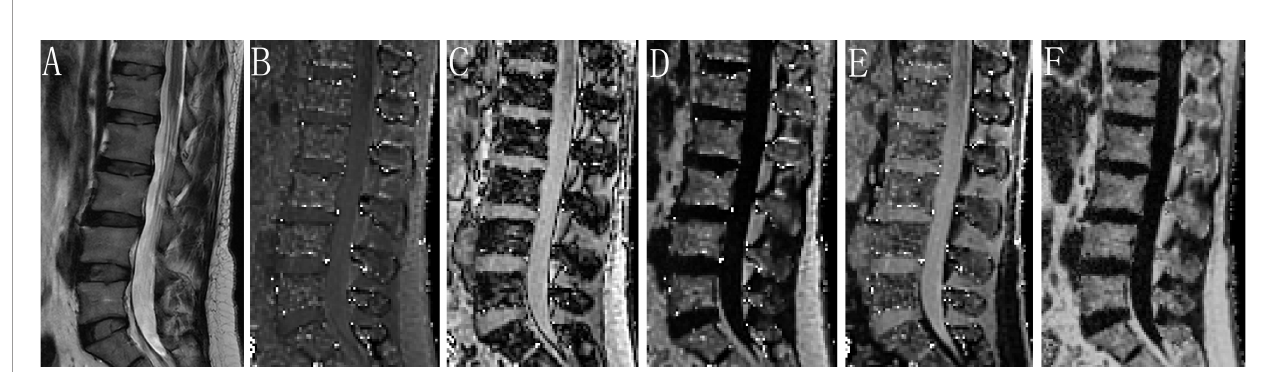
FIGURE 2 | Assessment of PDFF derived from six-echo FACT sequence in image set of a healthy woman. Sagittal T2-weighted (A) , in-phase (B) , out-of-phase (C) , fat-only (D) , water-only (E) , and the corresponding PDFF map (F) with a mean PDFF of 53% at the L1-L4 levels. FACT, Fat Analysis & Calculation Technique imaging; PDFF, proton density fat fraction.